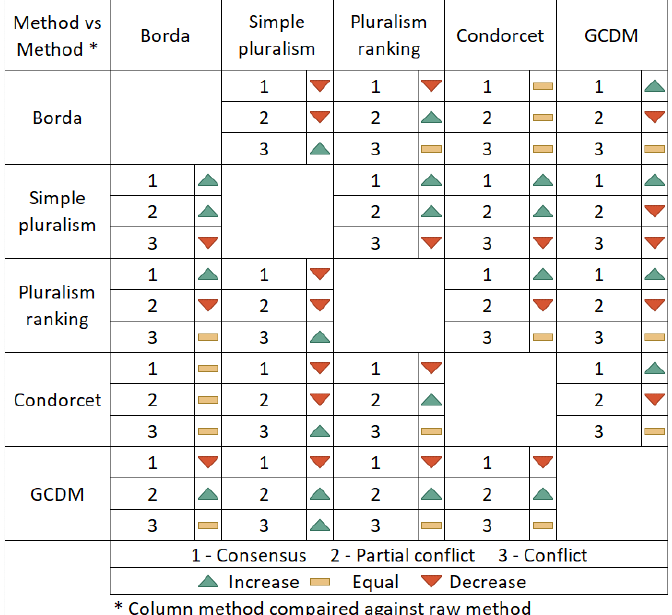
Figure 22. Increments and decrements among the distributions of the voting methods.